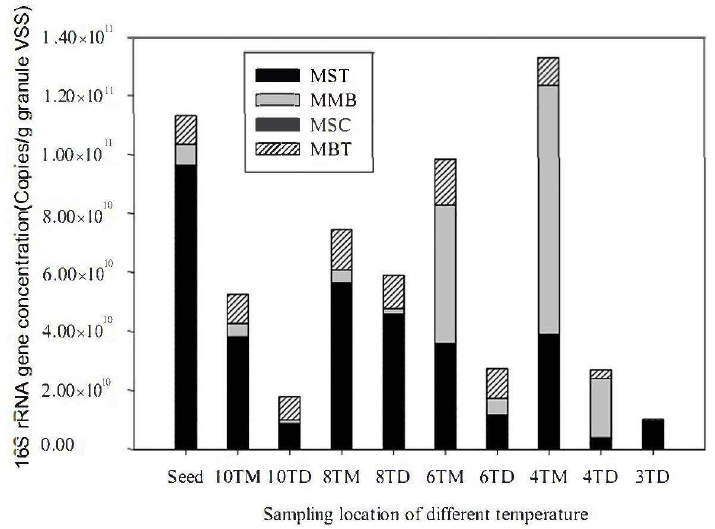
Figure 6. Quantitative changes in 16S rRNA gene concentrations for different methanogenic archaea in adherent and deposited sludge. Granular biomass samples were collected from seed inoculum (S), adherent sludge (TM), and deposited sludge (TD) of the four reactors. At 10 °C, 8 °C, 6 °C and 4 °C, the 16S rRNA gene concentration in the carbon-fiber carrier sludge was 65.82%, 20.61%, 72.13%, and 79.60% greater, respectively, than in the